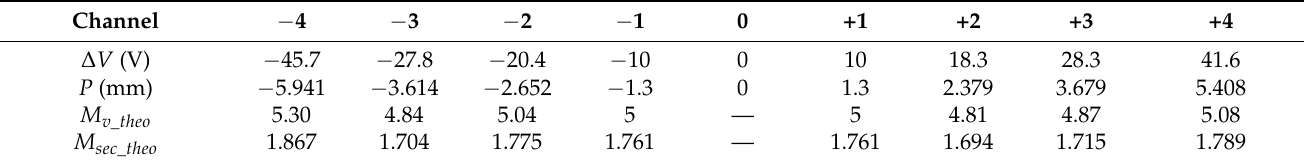
Table 4. Theoretical results.